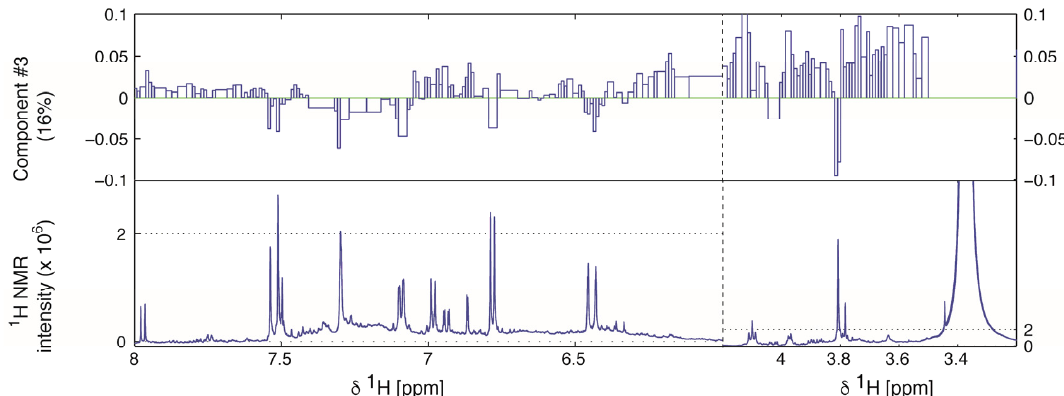
Figure 3. Two selected ranges of PCA-loading values of component #3 ( top row ) compared to 1 H-NMR spectra of the most active extract (sample 3). The vertical scaling of the loadings are the same in both ranges, whereas the vertical scaling in the 1 H-NMR spectrum is indicated by the horizontal grid line.